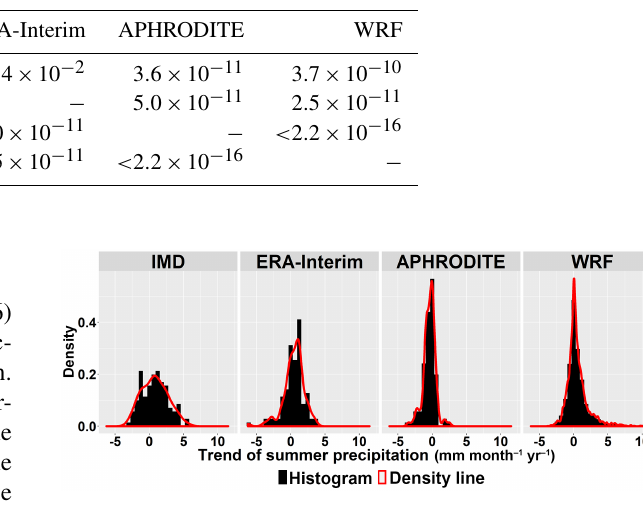
Figure 8. Density curves of trends (mmmonth − 1 year − 1 ) of sum- mer precipitation in all grid